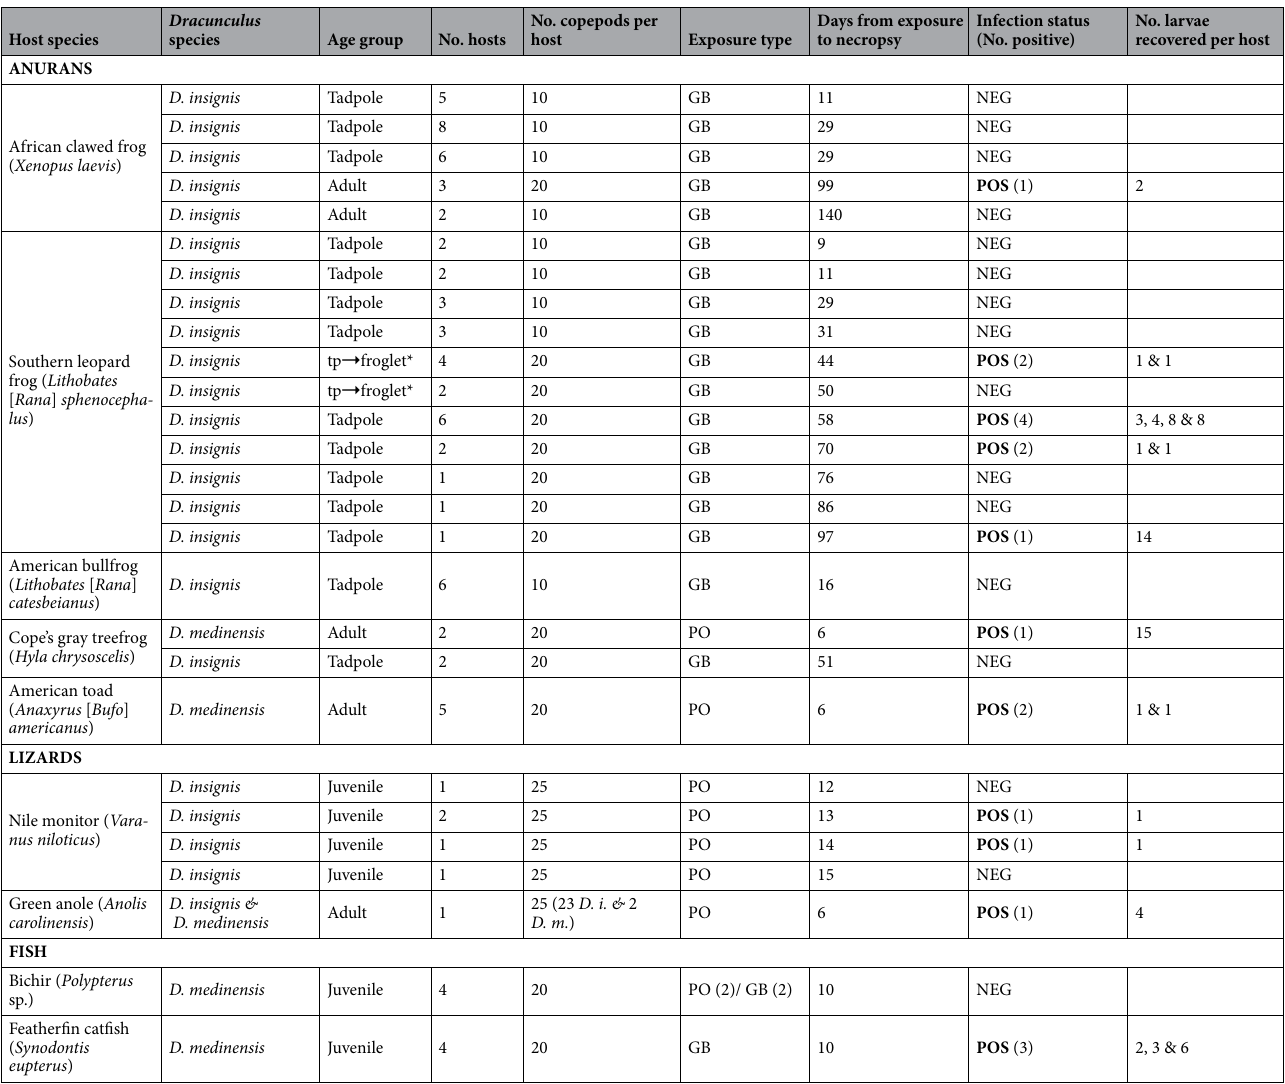
Table 1. Methods and results of paratenic host experimental infections with Dracunculus insignis or Dracunculus medinensis third-stage larvae (L3s) via ingestion of infected copepods. All larvae